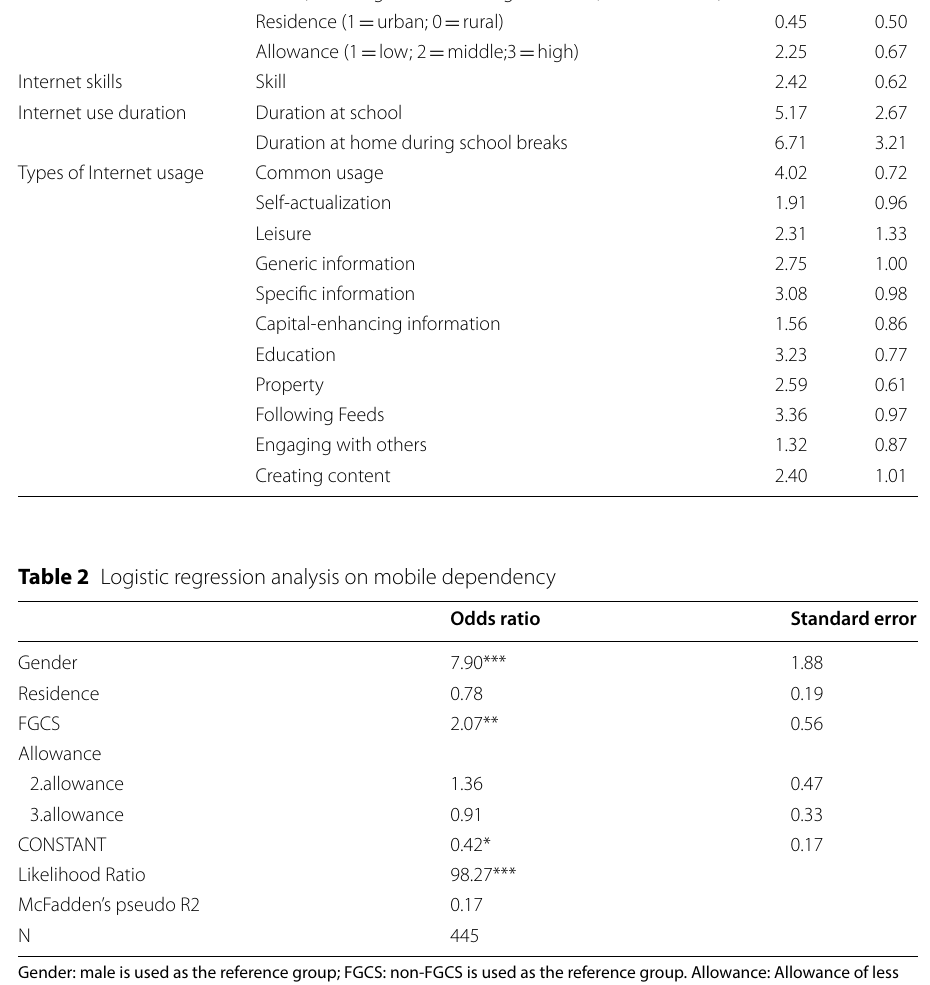
Gender: male is used as the reference group; FGCS: non-FGCS is used as the reference group. Allowance: Allowance of less than ¥1000 is used as the reference